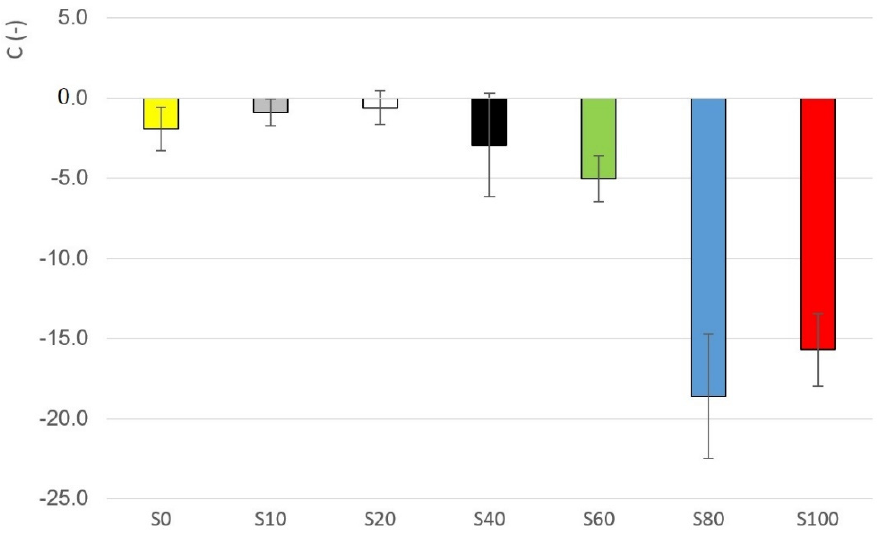
cosity ((cid:2015) ∗ ) on the angular frequency ((cid:2033)) .